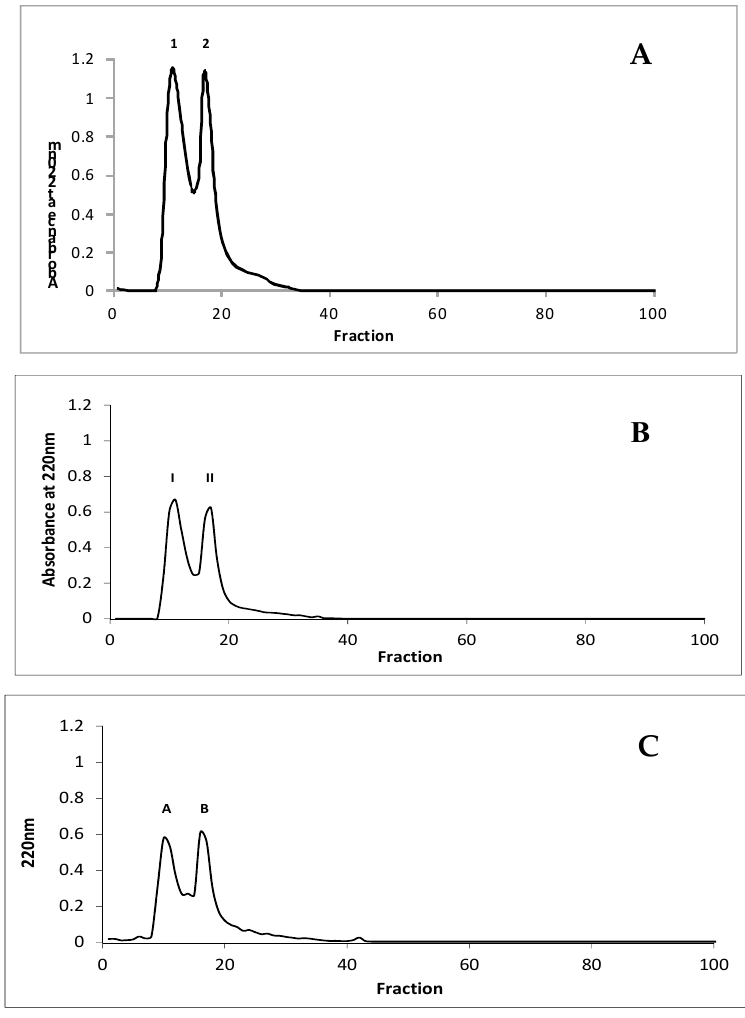
Figure 10. Peptides’ profile separated on Sephadex G10 (PRO P— A , G11S P— B , and PP— C ).